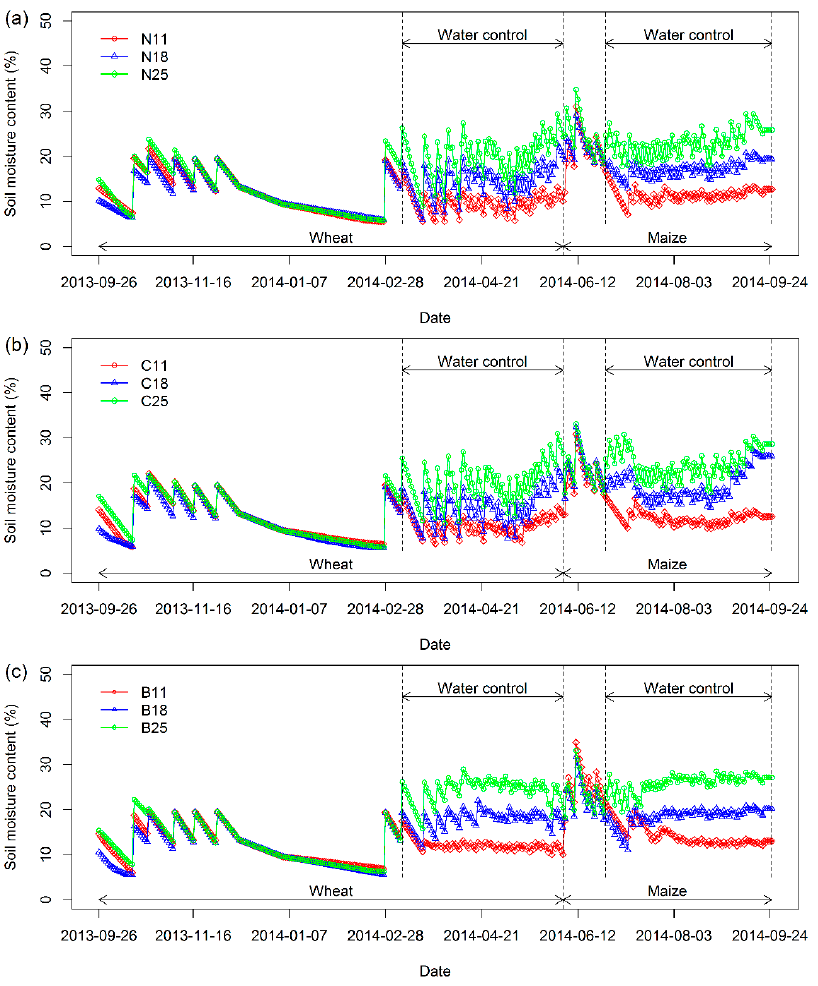
Figure 4. The soil moisture content changes measured in the pot experiments during the wheat and maize seasons. Soil moisture contents in pots were controlled at 11 ± 2%, 18 ± 2%, and 25 ± 2%, respectively, for ( a ) normal pots with crops (N11, N18, N25); ( b ) covered soil with a crop (C11, C18, C25); and ( c ) bare soil without a crop (B11, B18,